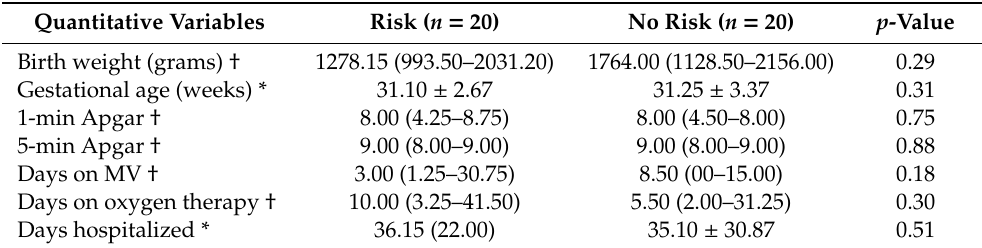
Table 3. Bivariate analysis of quantitative variables according to the risk of developing